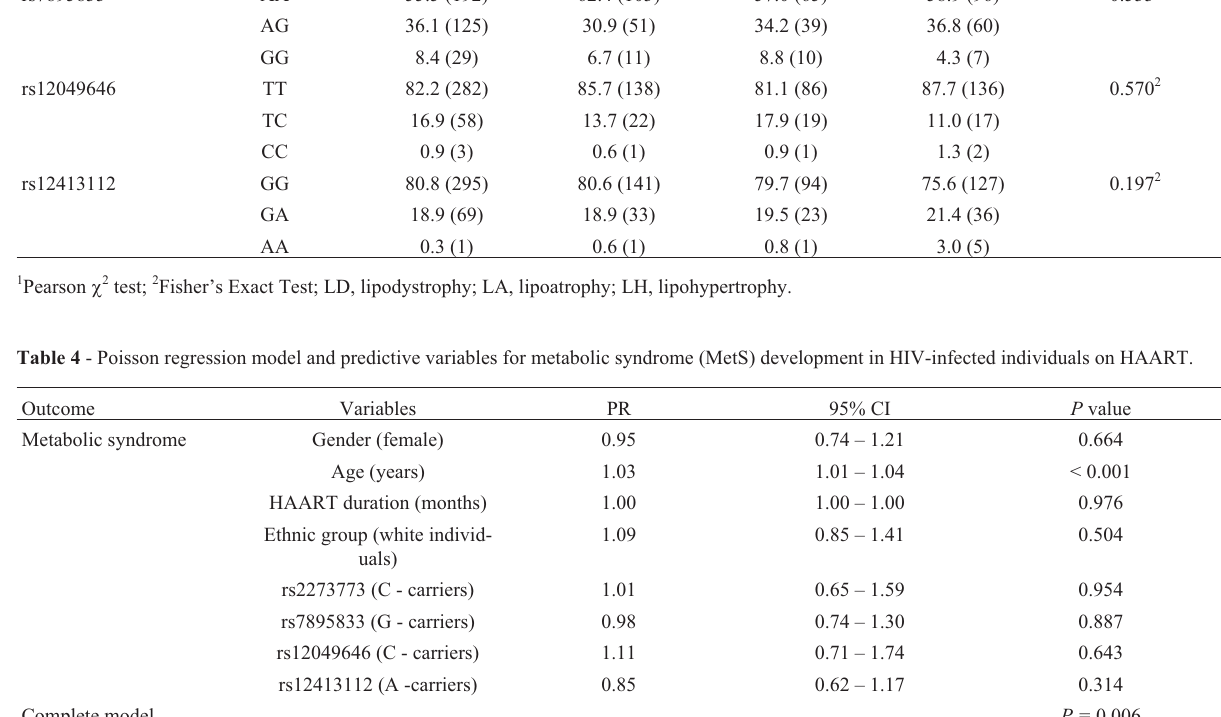
Complete model P = 0.006 PR, prevalence ratio, 95% CI; 95% confidence interval. Table 5 - Poisson regression model and predictive variables for lipodystrophy development in HIV-infected individuals on HAART. Outcome